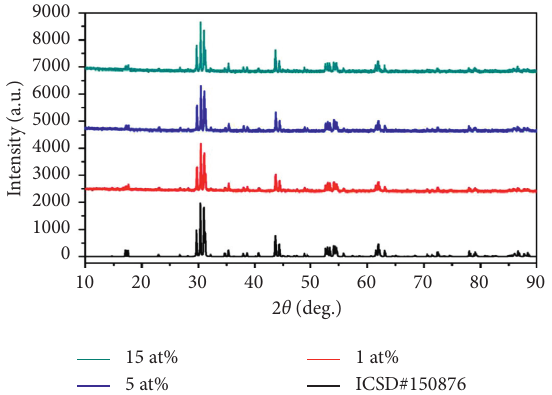
Figure 2: The XRD patterns of (1 at%, 5 at%, and 15 at%) SrLa Eu 3+ . Figure 5: The emission peak intensity value of the SrGd